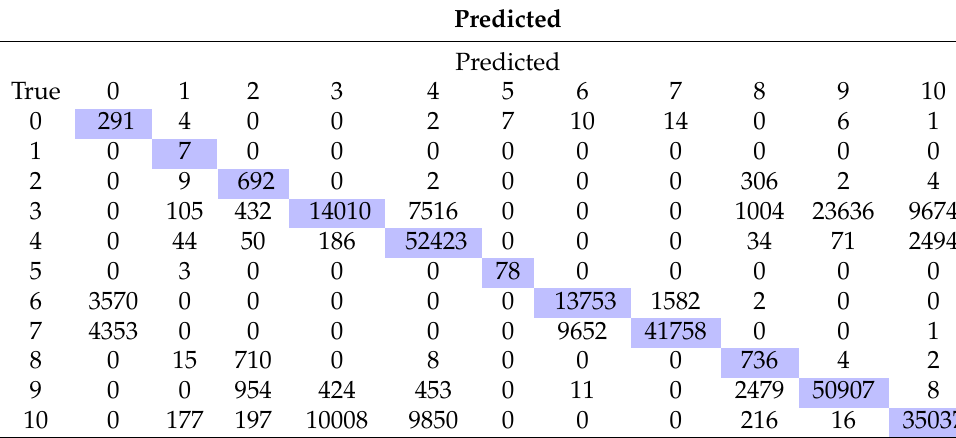
Table 53. LR weighted classes confusion